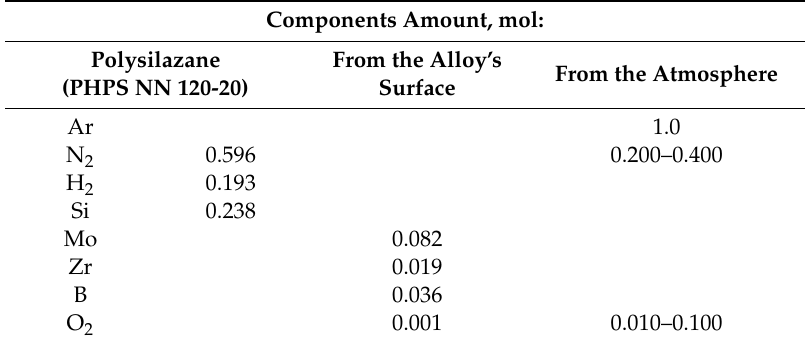
Table 1. Chemical composition of the system polysilazane (PHPS NN 120-20; Si–N 2 –H 2 ) alloy (Mo, Zr, B) and pyrolysis atmosphere (O 2 , N 2 ) used for thermodynamic